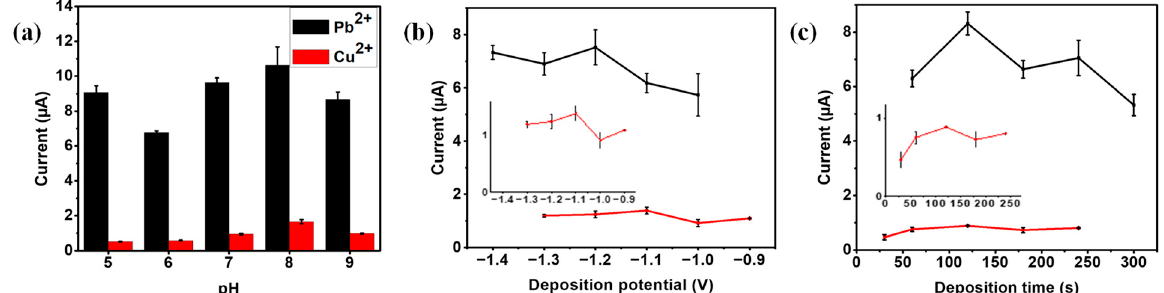
Figure 4. Current response of TC4/AuNPs/SPCE in detecting 1.0 ppm Pb 2+ and Cu 2+ in 0.1 M KCl solution with different ( a ) pH levels with a constant deposition potential of − 1.2 V and a deposition time of 120 s; ( b ) deposition potential with a constant deposition time of 120 s in pH 8, 0.1 M KCl solution; ( c ) deposition time with a constant deposition potential of − 1.2 V (Pb 2+ ) and − 1.1 V (Cu 2+ ) in pH 8, 0.1 M KCl solution using differential pulse voltammetry (DPV).